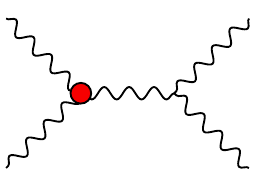
Figure 3 . Contribution to 4-point gluon scattering around scalar